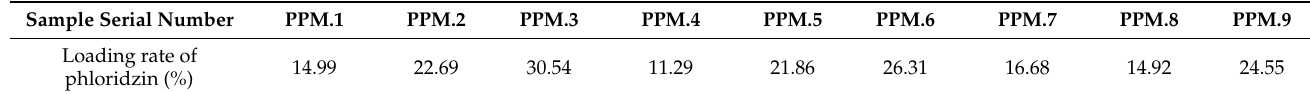
Table 4. The loading rate of phloridzin in phloridzin/MCM-41 assembly.